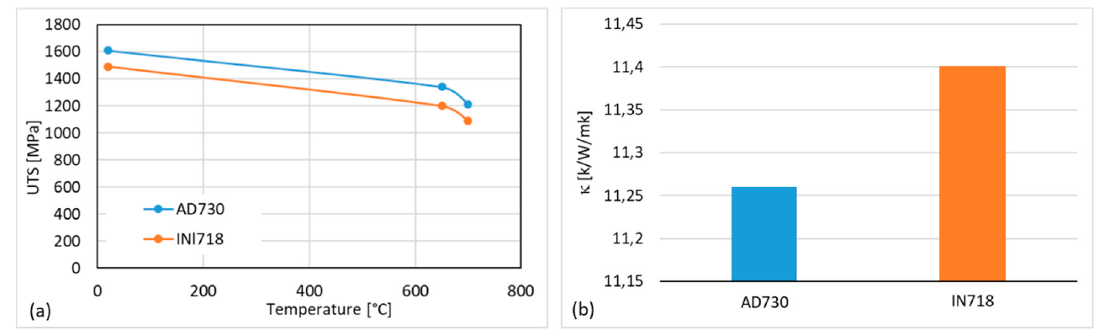
Figure 2. ( a ) Ultimate tensile strength (UTS) of AD730 ® and IN718 at different temperatures [2]; ( b ) Figure 1. Microstructures of ( a ) AD730 ® and ( b ) IN718. thermal conductivity ( κ ) of AD730 ® and IN718 at room temperature (RT) [26,27].